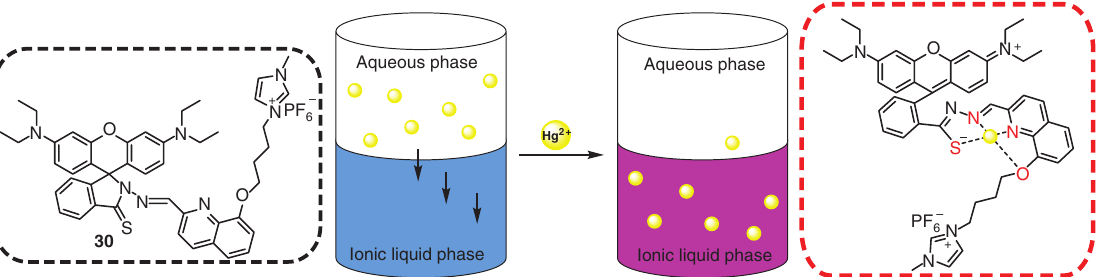
Figure 20: Structure, binding mechanism, and schematics of probe 31 -based bifunctional system for the removal and highly sensitive detection of HMIs via the synergistic extraction effect.